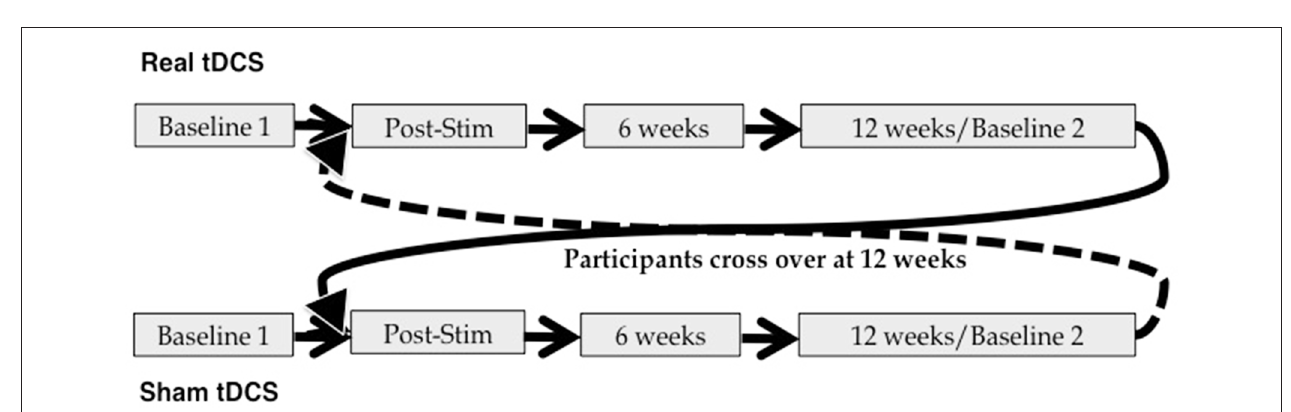
FIGURE 2 | Study design. Participants were randomized to begin in either the real or sham arm of the study, and crossed over at 12 weeks